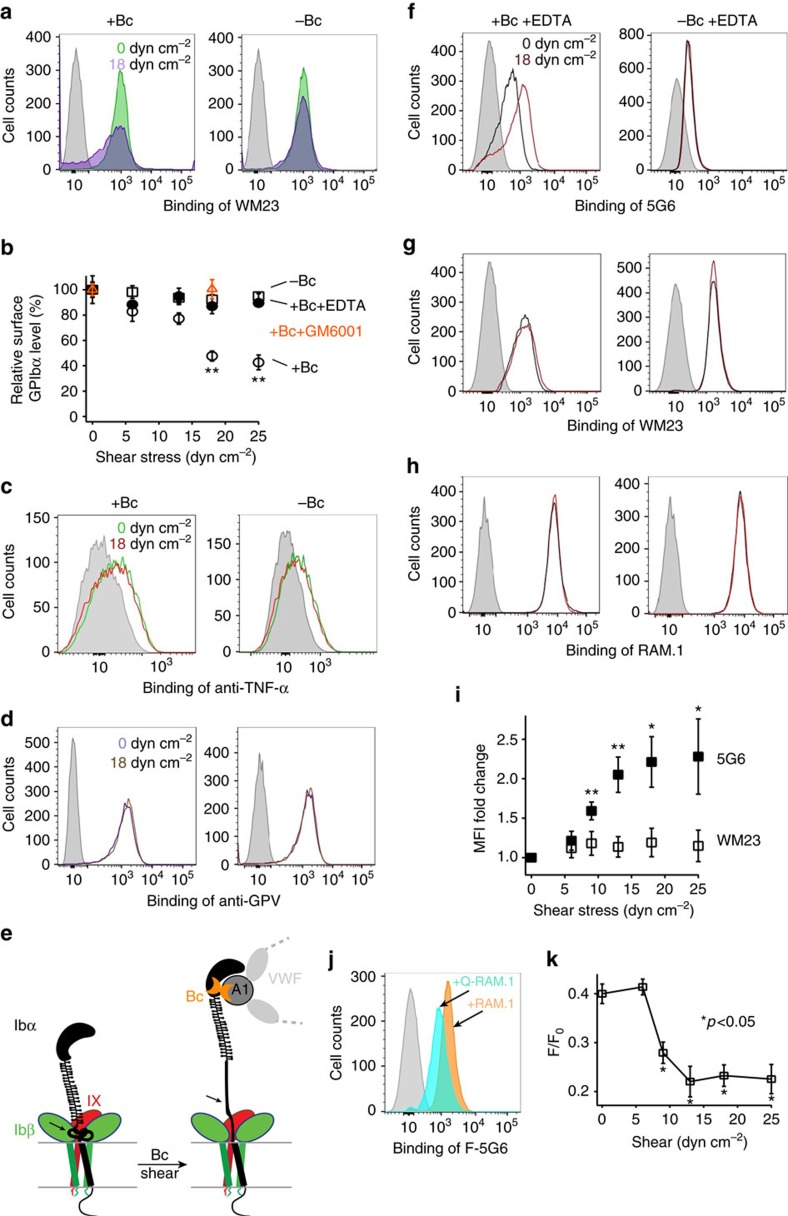
Botrocetin and physiological shear induce deformation of MSD on the platelet.(a) Flow histograms illustrating that botrocetin/shear reduced GPIbα level in human platelets as measured by binding of WM23. Grey: IgG control; green: no shear; purple: 18 dyn cm−2 shear. (b) Quantificated relative GPIbα levels as a function of shear stress. Median fluorescence intensity (MFI) under each condition was normalized to that under no shear being 100%. Open squares: with botrocetin (1 μg ml−1) and EDTA (+Bc+EDTA); filled circles: without botrocetin (−Bc); open circles: with botrocetin (+Bc); open orange triangles: with botrocetin and GM6001 (10 μM). Data are shown as mean±s.d. (n=3). P values are between +Bc and −Bc. **P<0.01. (c,d) Flow histograms illustrating the lack of change in pro-TNFα and GPV levels following botrocetin/shear treatment. (e) A diagram illustrating botrocetin/shear induces unfolding of the MSD in GPIb–IX, adapted from14. The ADAM17 cleavage site in the MSD is marked by the arrowhead. (f–h) Flow histograms illustrating botrocetin/shear-induced increase in 5G6 binding, but not in WM23 or RAM.1 binding. EDTA was added during treatment to prevent GPIbα shedding. (i) Quantificative plots of change in 5G6 binding versus WM23 binding as a function of shear stress. Filled square: 5G6 binding; open square: WM23 binding. Data are shown as mean±s.d. (n=3). *P<0.05. (j) Flow histograms illustrating fluorescence quenching of fluorescein-labelled 5G6 (F-5G6) by quencher-labelled RAM.1 (Q-RAM.1) on resting platelets in the absence of shear. (k) Shear-dependent change of the quenching efficiency (F/F0), in which F is the MFI value obtained with F-5G6 and Q-RAM.1, and F0 is that with F-5G6 and unlabelled RAM.1. Data are shown as mean±s.d. (n=3). P values are between shear and no shear treatment.